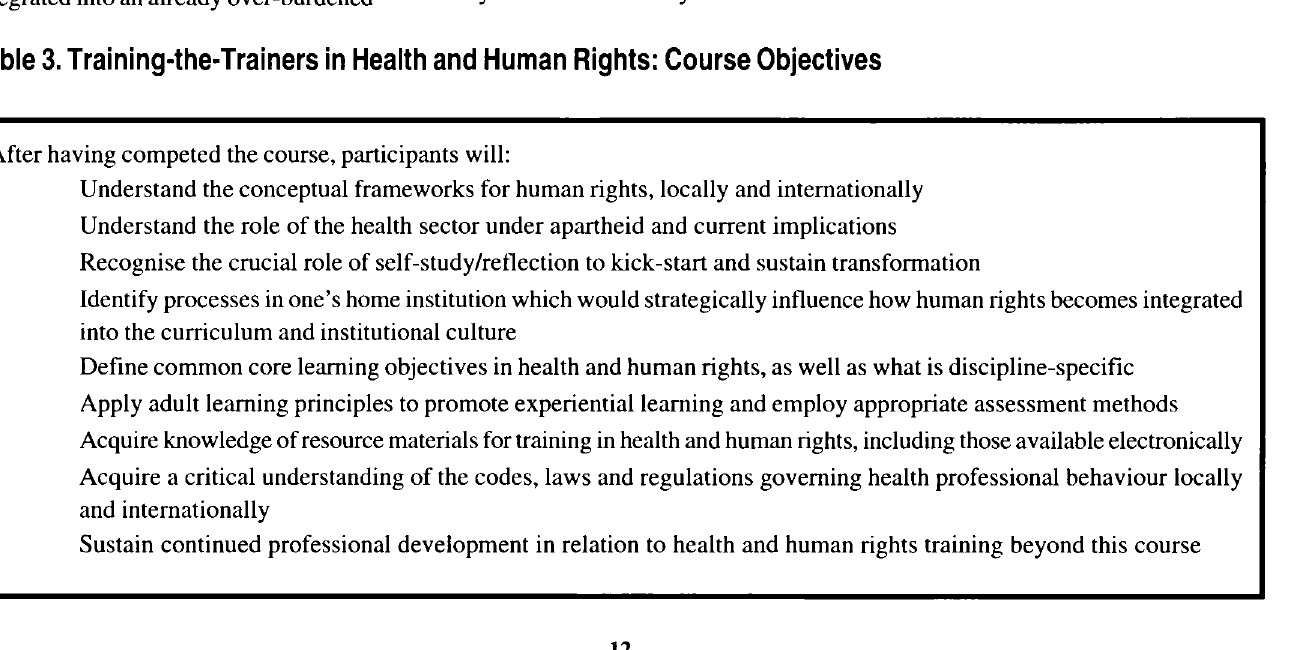
Table 3. Training-the-Trainers in Health and Human Rights: Course Objectives After having competed the course, participants